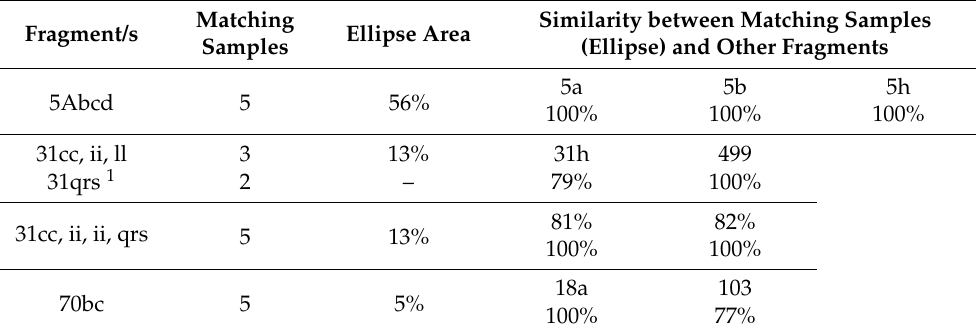
Figure 9. Averaged RGB CL colors projected on the median plane. Some values have been highlighted: in blue matching samples that define a confidence ellipse, and in red other samples that presumably also belong to the group. ( a ) 5Abcd and related fragments; ( b ) the samples as before, but in this case the confidence ellipse has been computed using the values of fragments 5a, 5b, and 5h that do not match; ( c ) 31-type matching fragments and related fragments, the dashed-line ellipse was computed using only 31cc, 31ii, and 31ll fragments; and ( d ) 70abc and related fragments. Table 6. Several groups of matching samples with the indication of the percentage area of the corresponding 95% confidence ellipse compared to the area of the general ellipse. On the right, the similarity between the group and isolated (not matching) fragments is shown.